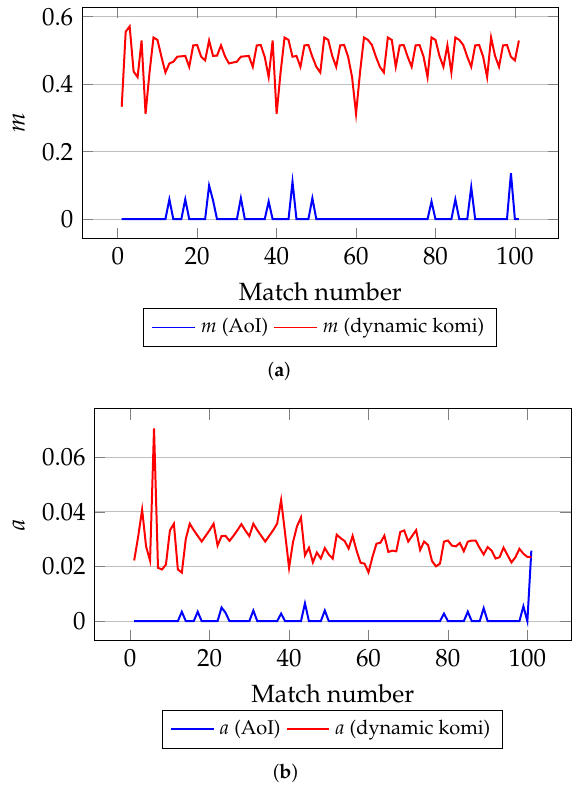
Figure 6. Illustration of the trend in m and a values over a number of matches comparing advantage of initiative and application of dynamic komi. ( a ) Illustration of m dynamics: process fairness with number of advantages and disadvantages is given by m = 1 dynamics: acceleration is given by a = 2 m